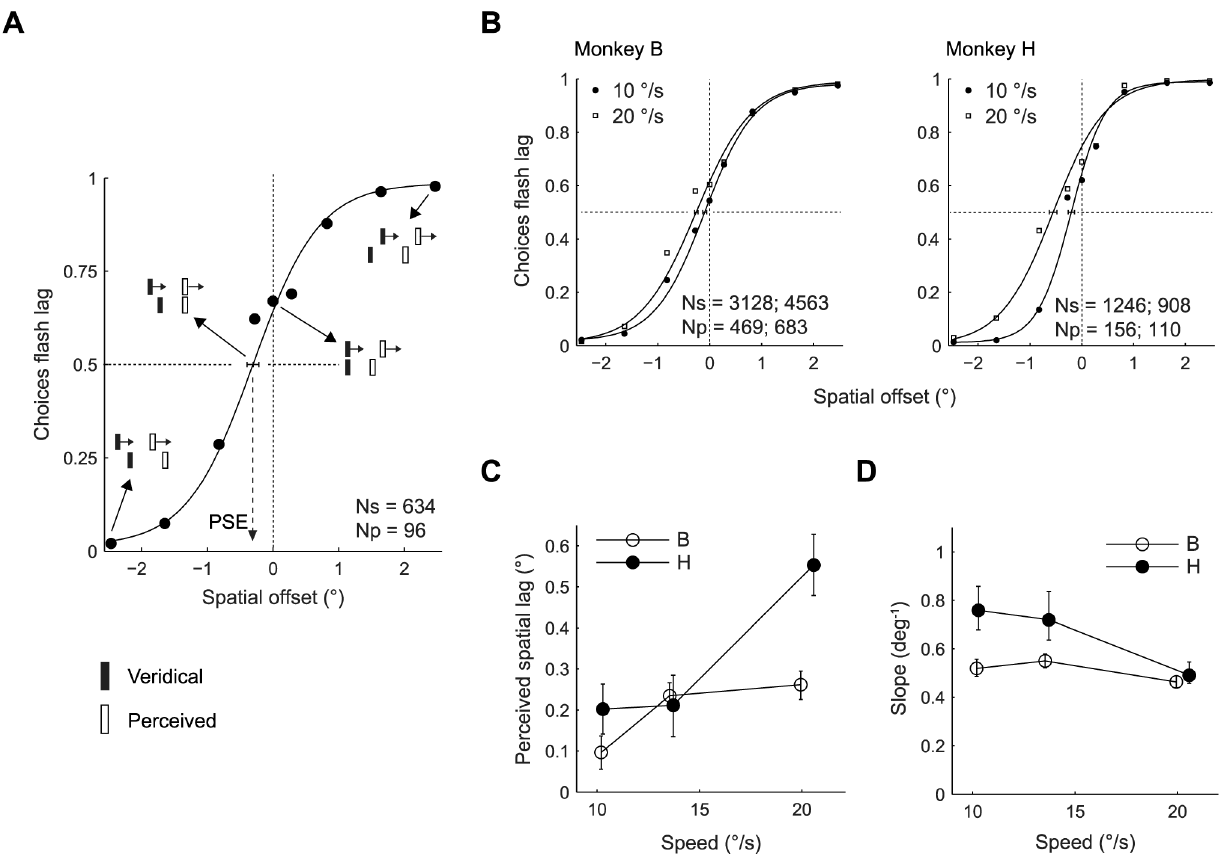
Figure 2. Monkeys perceive the flash lag illusion. (A) Psychometric function from a single session of monkey B for a moving bar speed of 20 u /s. The abscissa shows the veridical spatial offsets of the stimuli. The ordinate shows the probability of the monkey reporting that the flash lagged behind the moving bar. Four different points along the psychometric function are illustrated with cartoons of veridical stimuli (filled vertical bars) and hypothetical perceived stimuli (open vertical bars). The point of subjective equality (PSE) is the spatial offset at which the monkey reports the flash as lagging in 50% of trials (i.e. he perceived the two bars as vertically aligned). In this session the PSE was 2 0.31 u , indicating that the flash had to be placed 0.31 u ahead of the moving bar to make them perceptually aligned. Ns: average number of trials per suprathreshold spatial offset data point (spatial offset magnitude . 1.5 u ); Np: average number of trials per subthreshold spatial offset data point (spatial offset , 1.5 u ). Error bar: 95% bootstrap percentile-based plug-in estimate of confidence interval. (B) Psychometric function fit of the pooled responses (5–8 sessions) of monkeys B and H. For clarity, data from only two speeds (10 and 20 u /s) are shown. Ns and Np: as in A. For the speed that is not shown (14 u /s): for monkey B, Ns=4061 and Np=628; for monkey H, Ns=852 and Np=108. Error bars as in A.(C) Perceived spatial lag for monkey B (open circles) and monkey H (filled circles), as a function of the speed of the moving bar. Each data point is the PSE estimated from the psychometric function fit (shown in panel B) of responses pooled from five to eight sessions. Error bars as in A.(D) Slope of the psychometric functions measured at the threshold point (0.5 on the ordinate). Coding and error bars as in C.